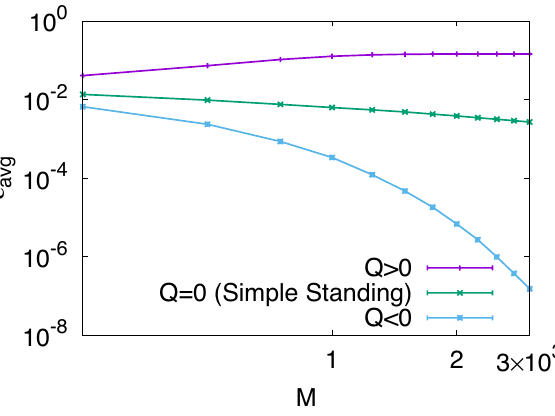
Figure 1. Recovery from disagreement when M rounds have elapsed in a population of size N = 50 with common α and β . Initially, we randomly pick up 20% of the image-matrix elements and change them to 0.9, whereas the rest of them remain as 1’s, and the simulation has been repeated over 10 3 independent samples without error, i.e., e = γ = 0 . In this log-log plot, the vertical axis shows the average difference from the state of perfect reputation, represented by the average of ε ki ≡ 1 − m ki . We have tested three norms, which all have α( 1, 1, 1 ) = 1 and β( 1, 1 ) = 1 but differ in their local slopes there: The first norm has ( A x , A y , A z ) = ( 0.2, 0.9, 0.1 ) and ( B x , B y ) = ( 0.2, 0.8 ) , which together yield Q ≡ − 1 + A x + A z + A y ( B x + B y ) > 0 [Eq. (17)]. The next one is Simple Standing with ( A x , A y , A z ) = ( 1, 0, 1 ) and ( B x , B y ) = ( 0, 1 ) , which has Q = 0 . The last one for Q < 0 is a variant of Simple Standing with ( A x , A y , A z ) = ( 0, 0.9, 0 ) and ( B x , B y ) = ( 0, 0.9 )